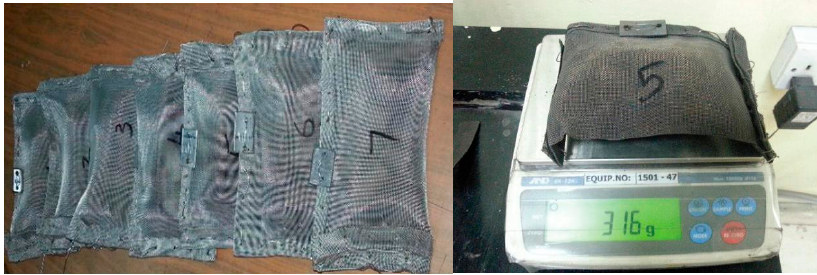
Figure 1. Deformable steel packages for feeding of Extruded Briquettes (brex) into Midrex reactor.